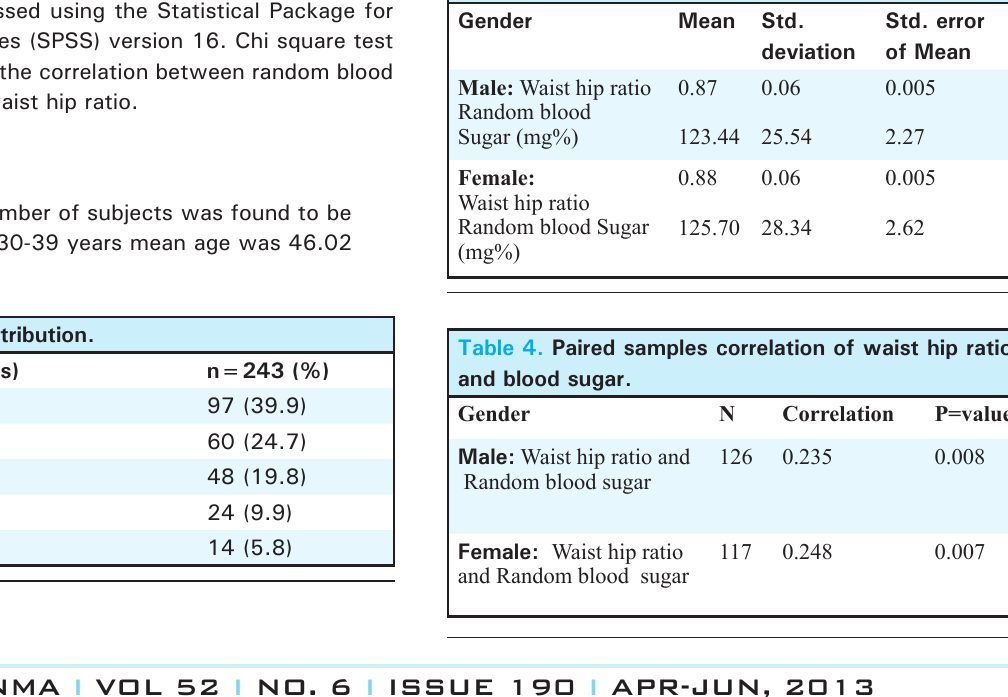
Table 3. Paired sample statistics of waist hip ratio and random blood sugar.